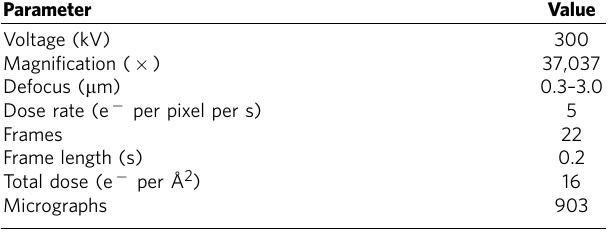
Table 1 | Nucleocapsid cryo-EM data collection parameters.